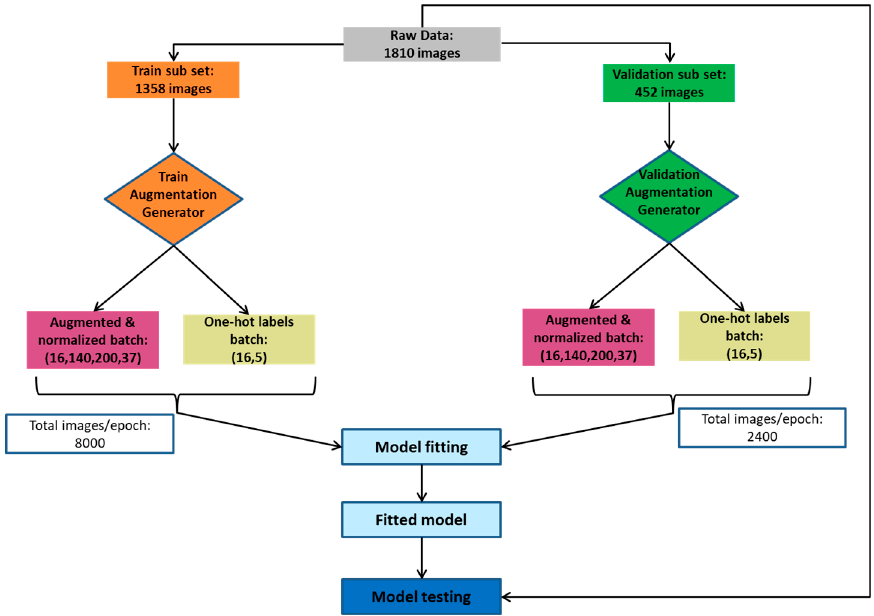
Figure 9. Workflow of the data augmentation process.